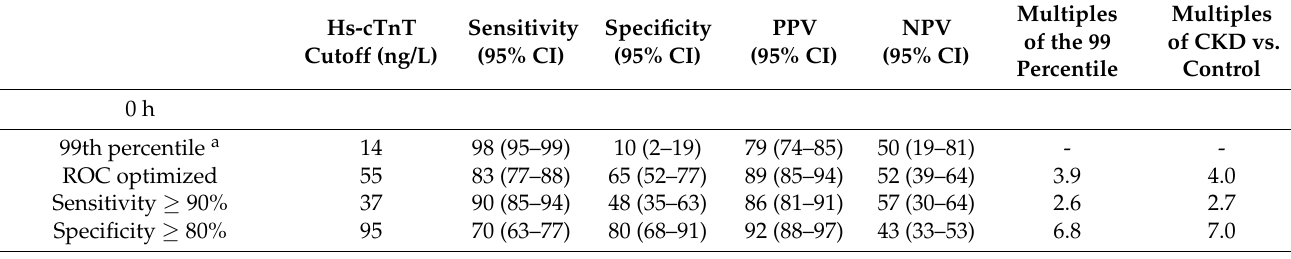
Table 2. Diagnostic performance of hs-cTnT in patients with severe